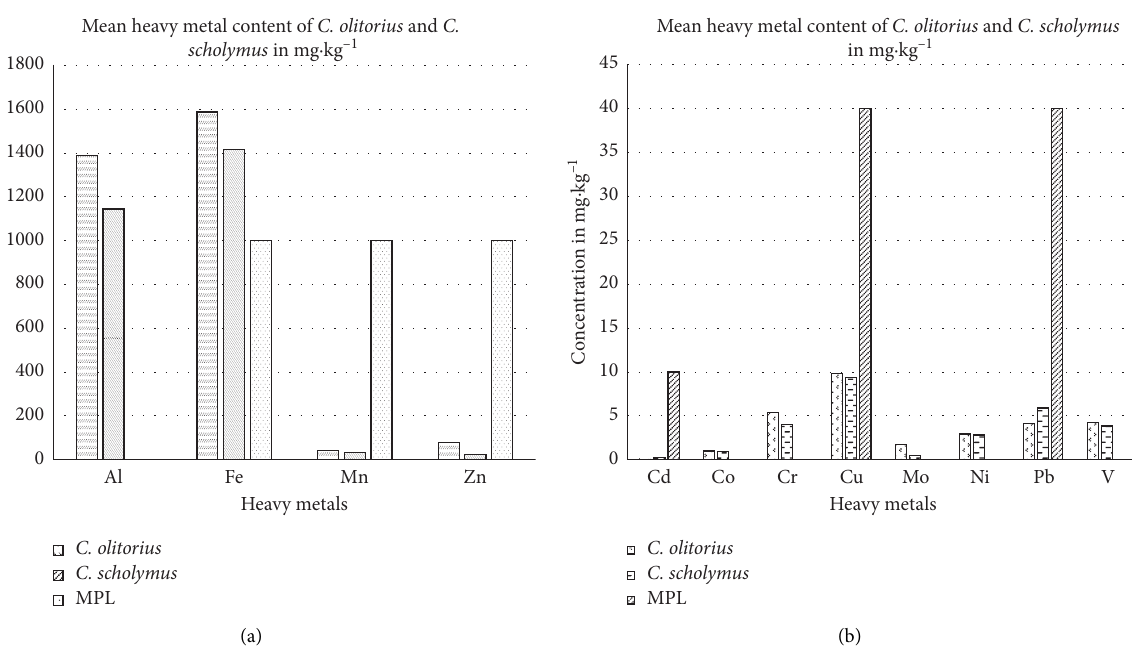
Figure 5: (a) Mean heavy metal content of C . olitorius and C . scholymus from the three sites. (b) Mean heavy metal content of C . olitorius and C . scholymus from the three